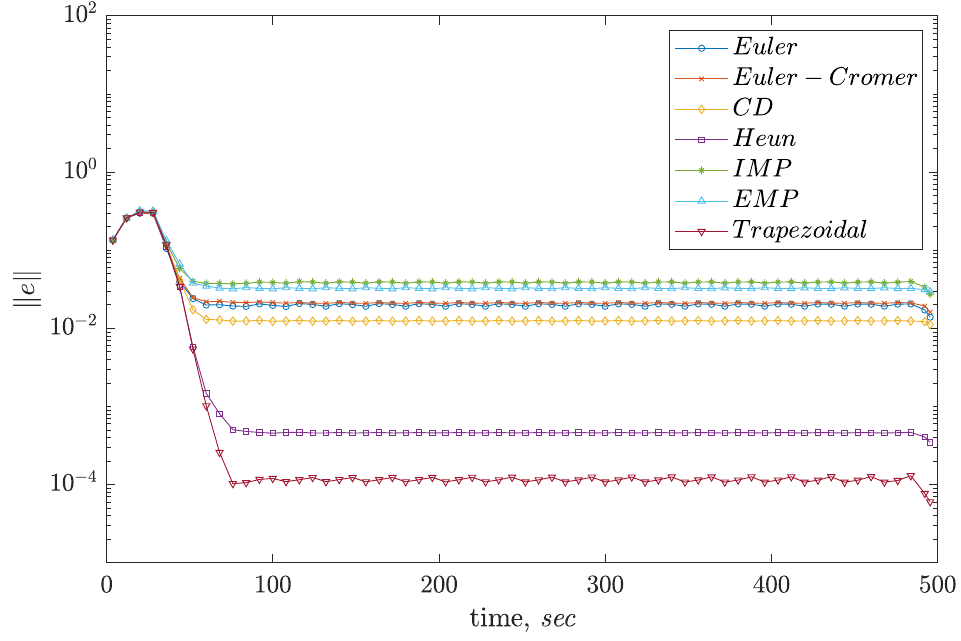
Figure 3. Synchronization error between master and slave systems for different integration methods, smoothed with a median filter; the window size is 600